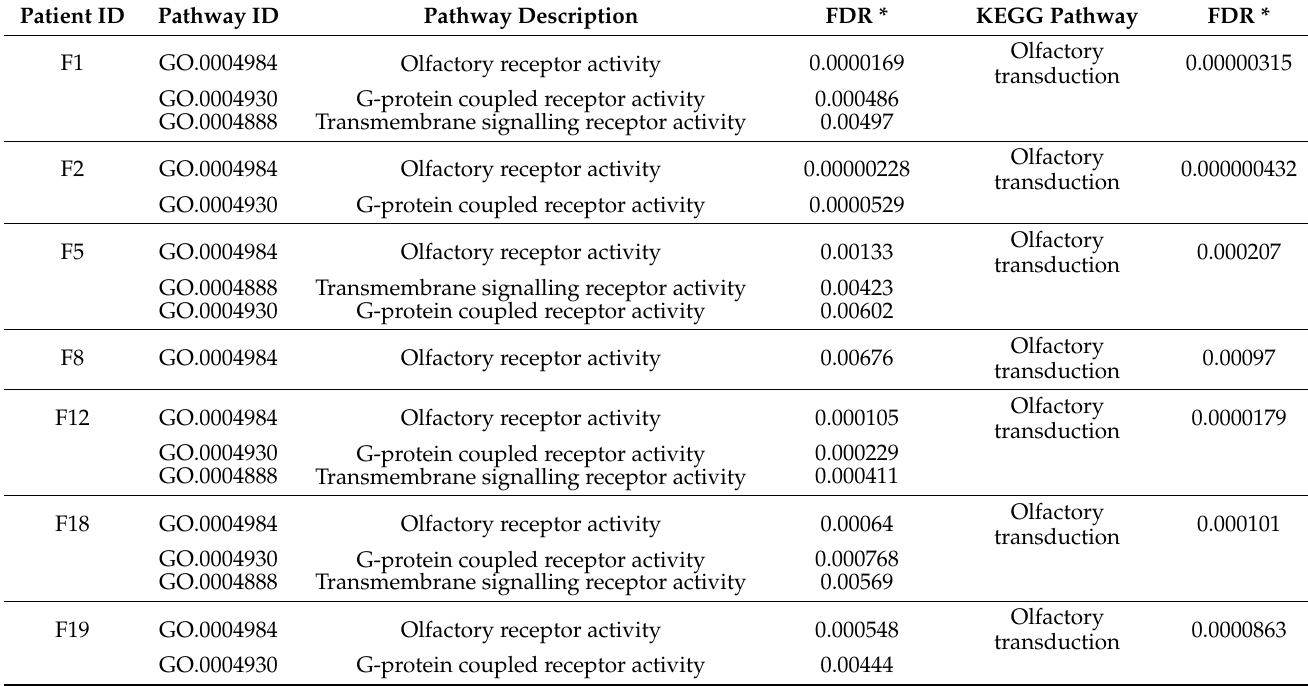
Table 3. Significant pathways identified in the seven whole-genome samples of CRC